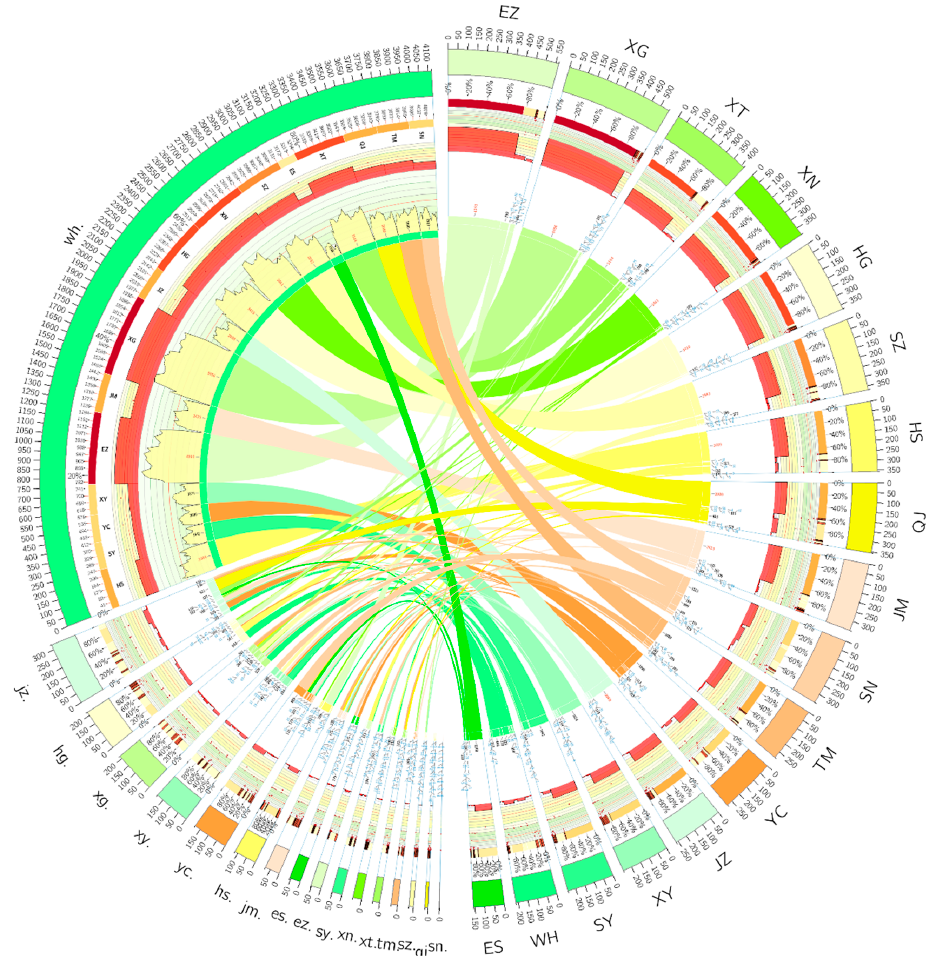
Figure 3. Inter-population migration from 1 January 2020 to 31 January 2020. Note: (1) The capital letters and non-capital letters in the outer circles represent the cities people move out of and move into. (2) All scale labels represent the number of migrations in the corresponding area. (Multiply everything by 0.1 except the percentage and the innermost circle scale). (3) The scatter points are distributed at different levels; the line chart and the histogram show the sub-level composition of the migration information of each region. (4) The strips with different color and widths in the center of the circle diagram visually show the migration direction and quantity from move-out areas (Note those with capital letters in the outer circles, such as: EZ) to move-in areas (Note those with non- capital letters in the outer circles, such as: ez.).